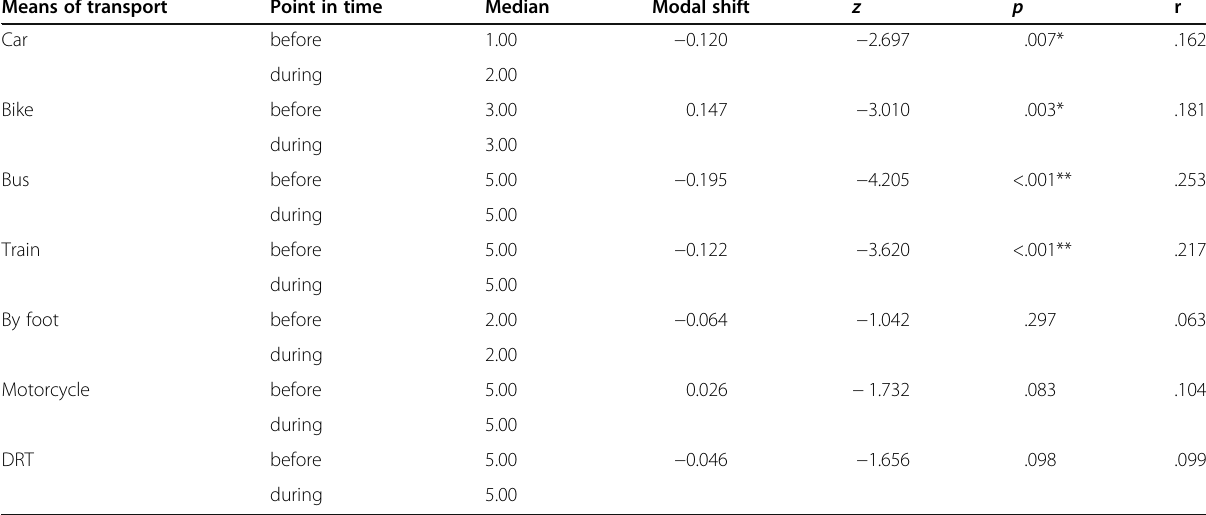
Table 2 Comparison of modal split before and during the corona pandemic situation ( N = 275) Means of transport